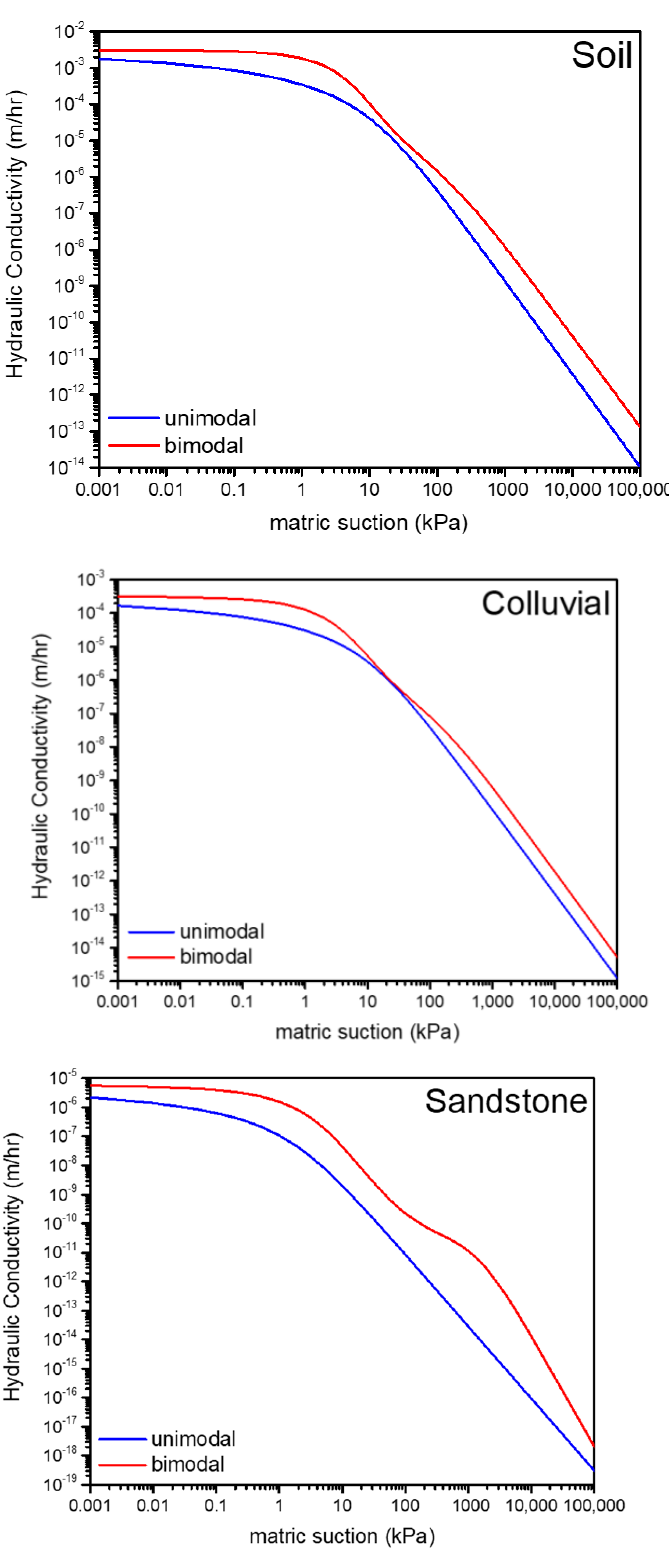
Figure 4. Estimation of unimodal and bimodal hydraulic conductivity function of soil, colluvial, and sandstone.